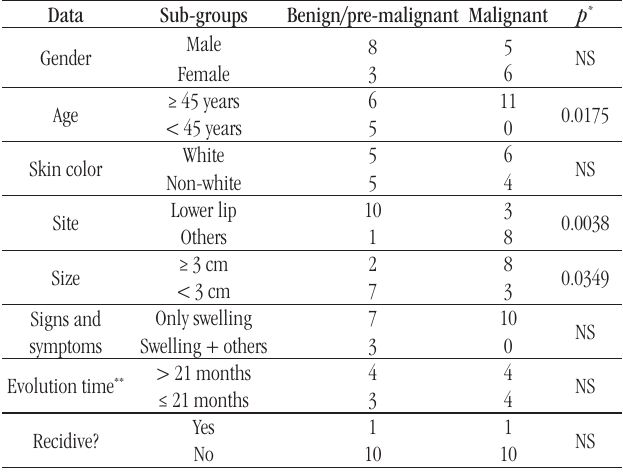
TABLE 3 – Contingency table demonstrating the associations between underlying pathology nature and clinical pathological features